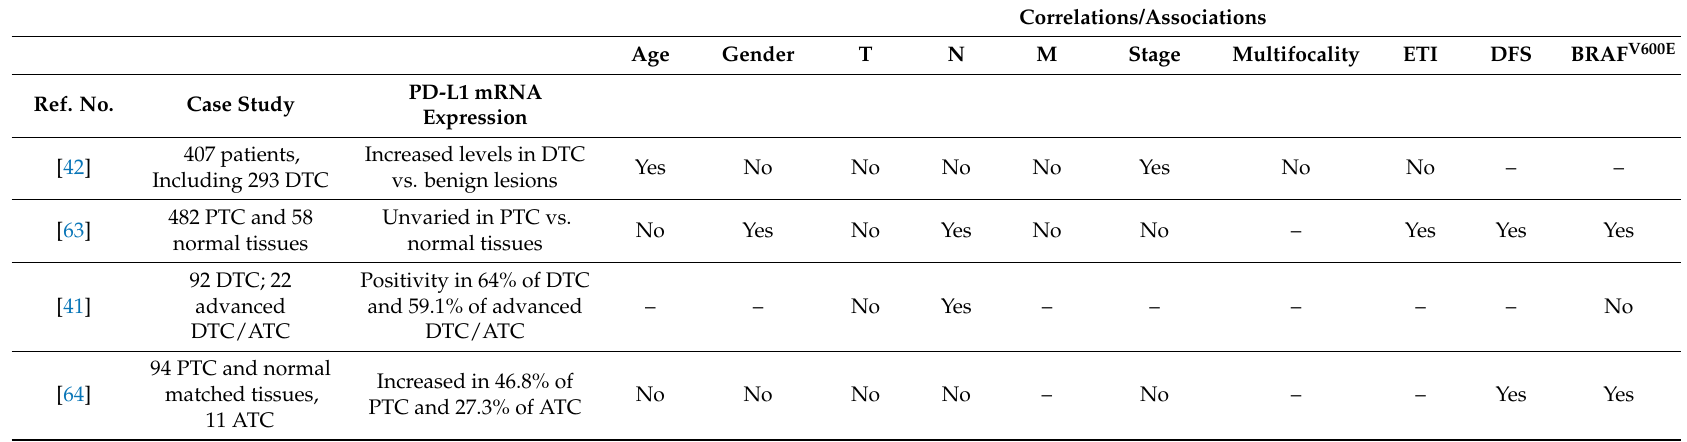
Table 2. Association of PD-L1 mRNA levels with clinico-pathological features and BRAF mutational status in thyroid cancer patients. ETI, extra-thyroidal invasion; DTC, differentiated thyroid cancer; PTC, papillary thyroid cancer; ATC, anaplastic thyroid cancer; –, non-evaluated; DFS, disease-free survival. Correlations/Associations Age Gender T N M Stage Multifocality ETI DFS BRAF V600E Ref.